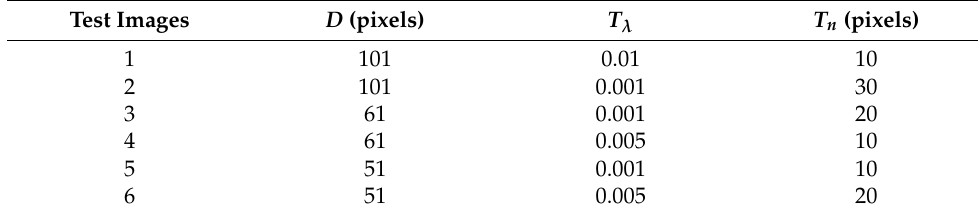
Table 1. Parameters used in the test images.